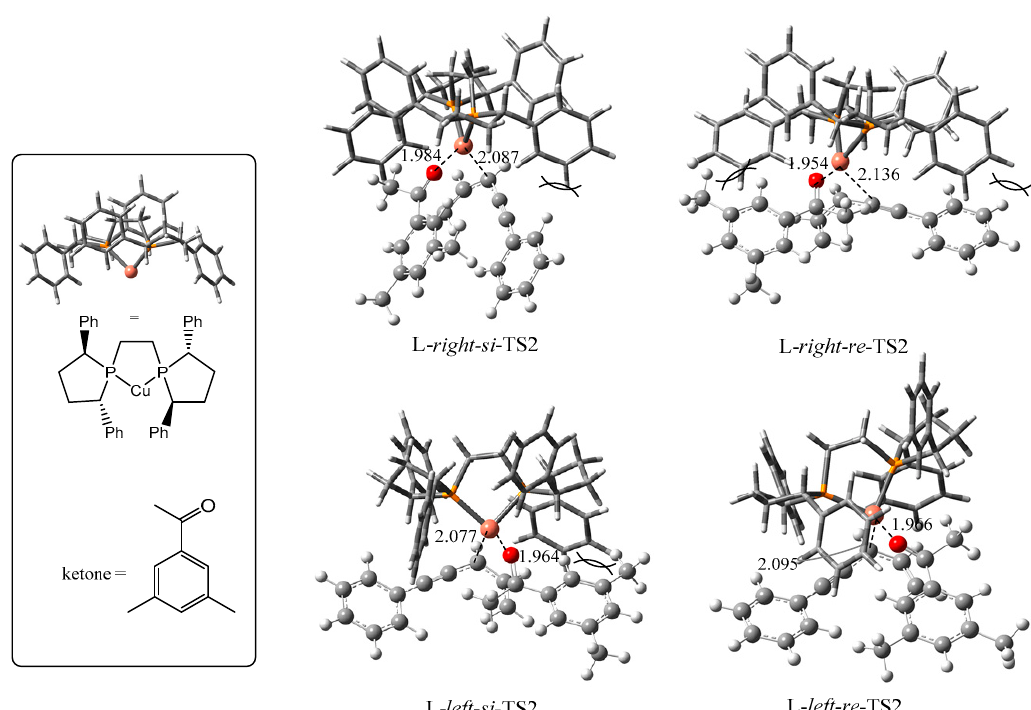
Figure 7. 3D model of stereo-controlling transition states ( TS2 s) at the M06/6-31G(d,p) in the 2,4-dimethylacetophenone/( S,S )-Ph-BPE ligand system.